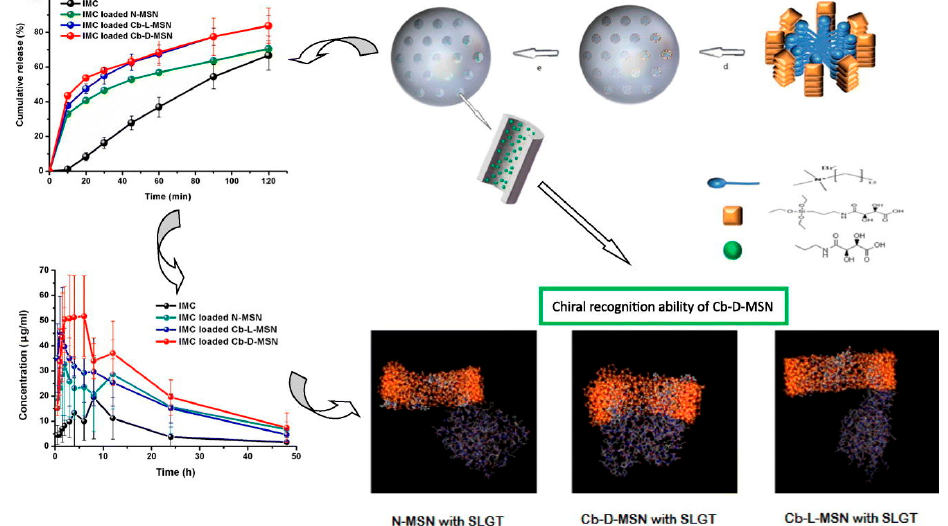
Figure 7. Enantioselective recognition and release of indomethacin (IMC) by means of concealed-body chiral MSNs prepared with either L- or D-tartaric acid. Reprinted with permission from [75], Copyright Elsevier,